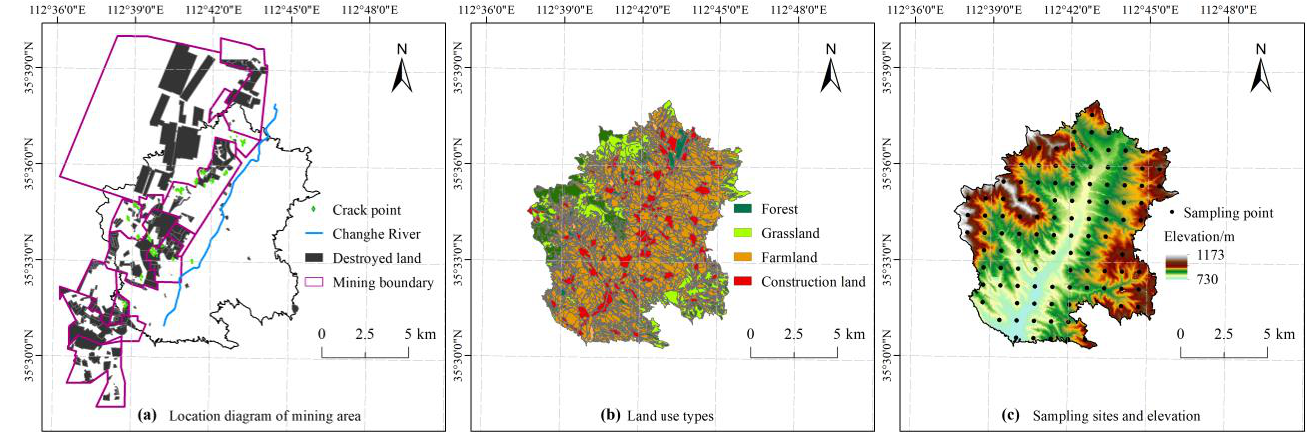
Figure 1. Study area, land use types, and soil sampling sites.